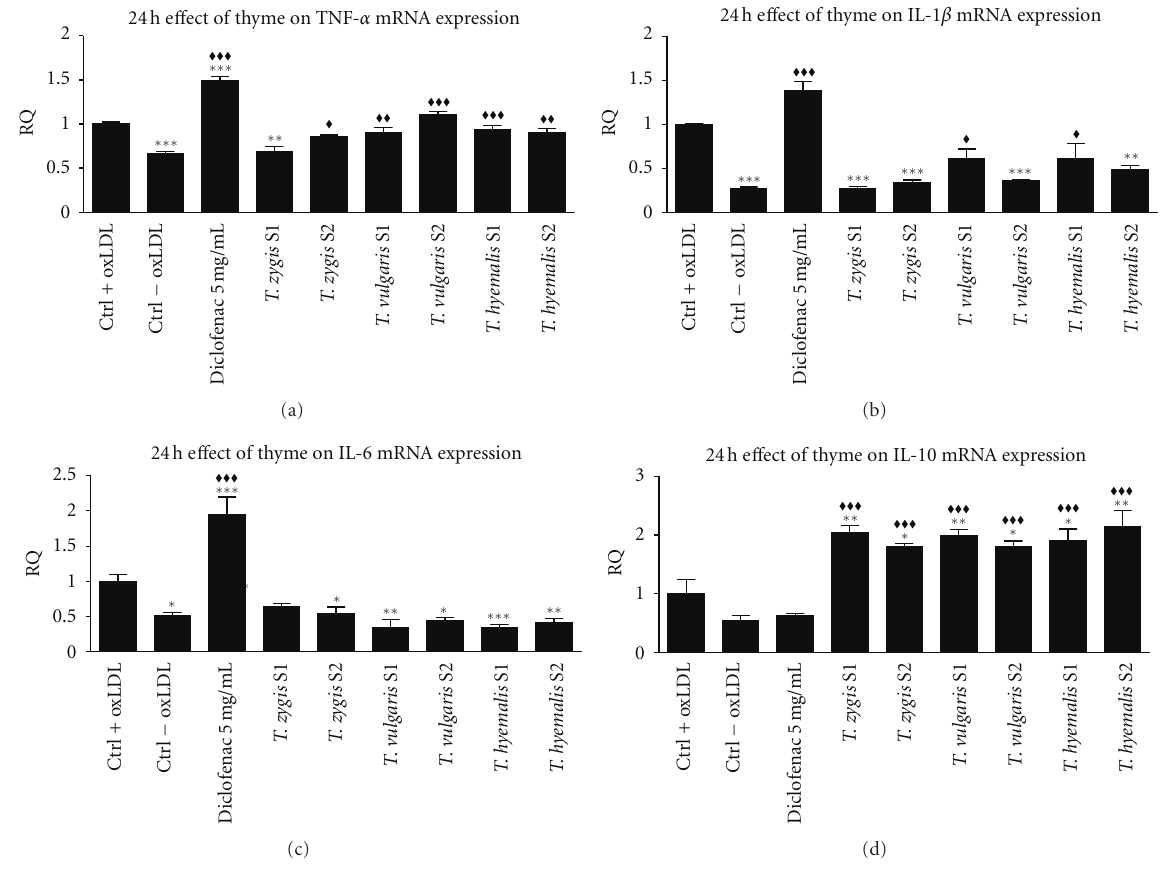
Figure 5: E ff ect of 25 μ g/mL of thyme extracts S1 and S2 from three di ff erent species ( Thymus vulgaris, Thymus zygis, and Thymus hyemalis ) on the relative quantification (RQ) of TNF- α gene expression (a), IL-1 β (b), IL-6 (c), and IL-10 (d) on macrophage-THP-1 cells. Cells were di ff erentiated with (PMA) 100ng/mL for and afterwards treated as described in Section 3 for 24 hours. Data represent means ± SEM calculated from six independent experiments with 3 replications for each treatment. Statistic Dunnett’s multiple comparison test versus Ctrl +oxLDL signification is represented by ∗ P values less than 0.05, significant; ∗∗ P values less than 0.01, very significant; and ∗∗∗ P values less than 0.001, extremely significant. Statistic Bonferroni multiple comparison test versus Ctrl − oxLDL signification is represented by (cid:3)(cid:3) P values less than 0.01, very significant; and (cid:3)(cid:3)(cid:3) P values less than 0.001, extremely significant. One group was treated with a small concentration of diclofenac (5 μ g/mL) as positive standard